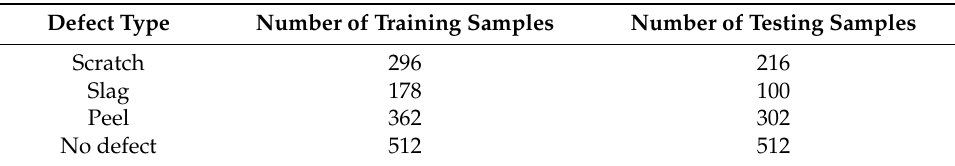
Figure 5. Flowchart of the experiment. Table 1. The number of training and testing samples.